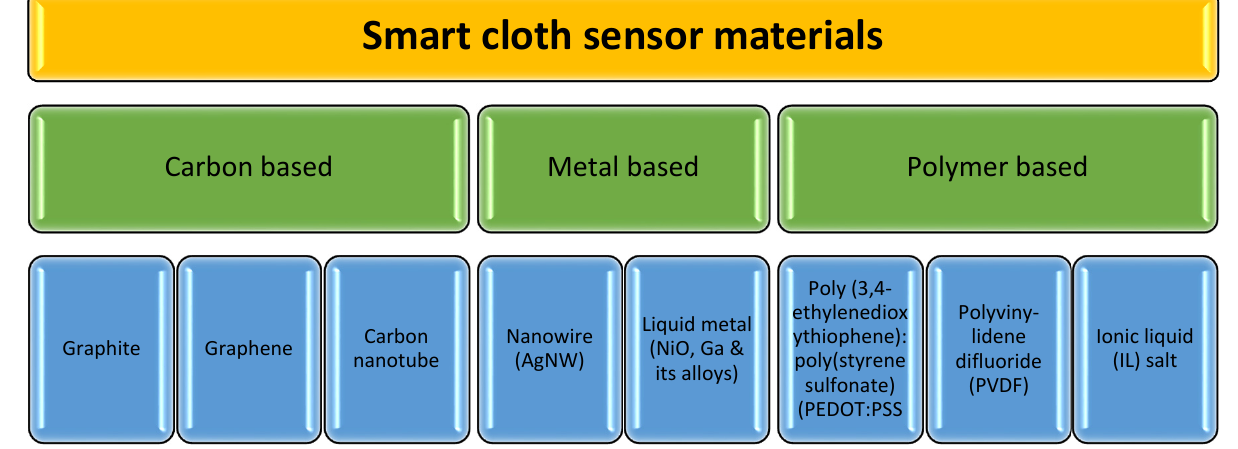
Figure 15. Sensor materials for smart clothing.